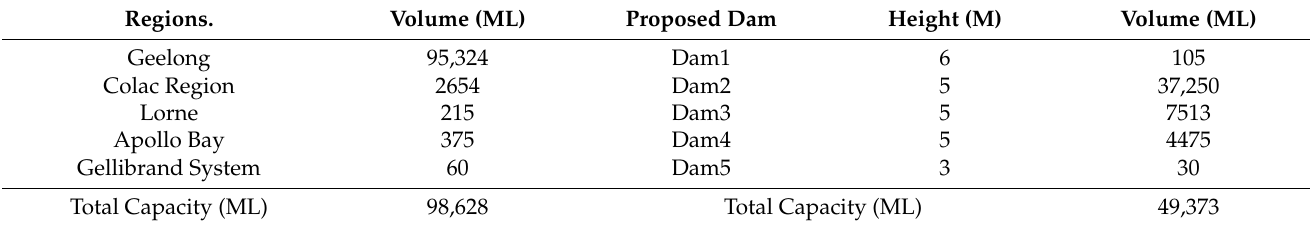
Table 3. The volumes of the proposed dam are compared to the original water storage capacity in Barwon.